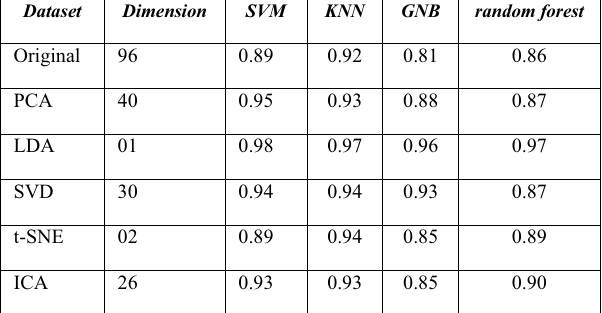
Table 4. performance of original and reduced datasets using multiple MLAs in terms of F1-score